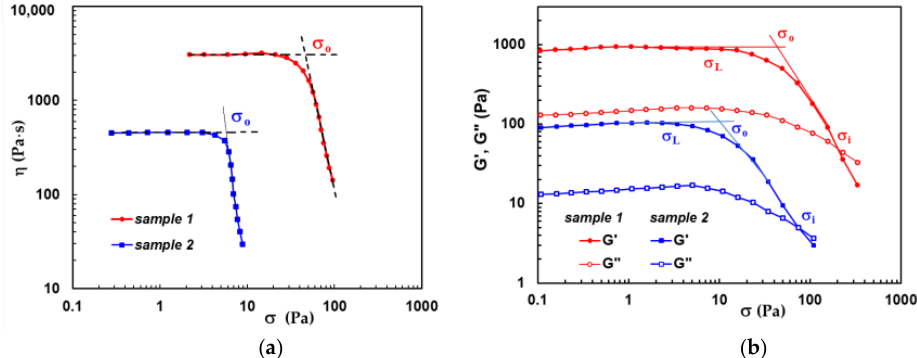
Figure 4. Illustration of yield stress determination from ( a ) the dependence of shear viscosity as a function of shear stress determined in continuous shear conditions [93]; ( b ) from the variation of the viscoelastic moduli as a function of shear stress in amplitude sweep tests. Two hydrogels were considered for this discussion: sample 1 contains 30% BSA and 70% polymer and sample 2 is composed of 70% BSA and 30% polymer. The polymer is a mixture containing 25% pullulan and 75% PVA [98].